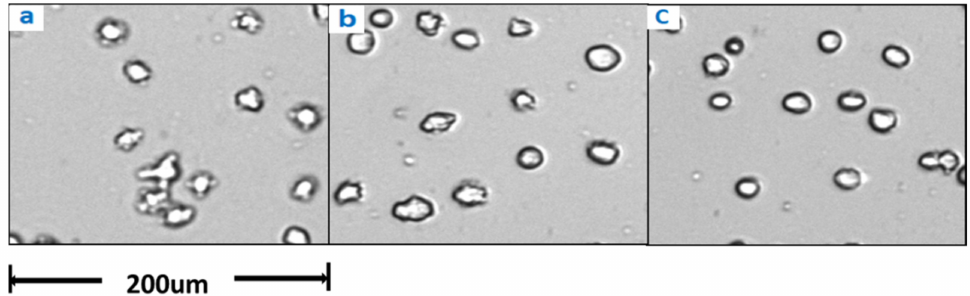
Figure 9. Changes in cell morphology after glucose withdrawal for 12 h ( a ) before glucose supple- mentation, ( b ) 24 h after glucose supplementation, and ( c ) 48 h after glucose